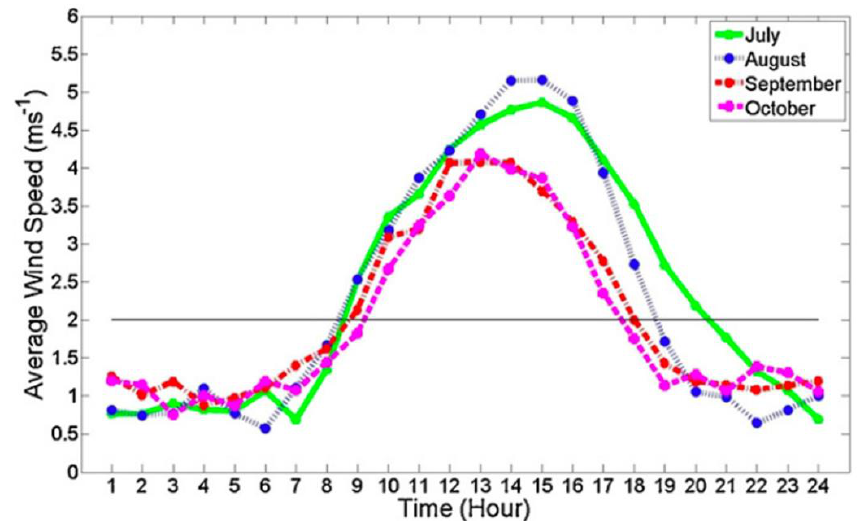
Figure 7. Monthly mean hourly wind speed in 2008 from July to October [12].